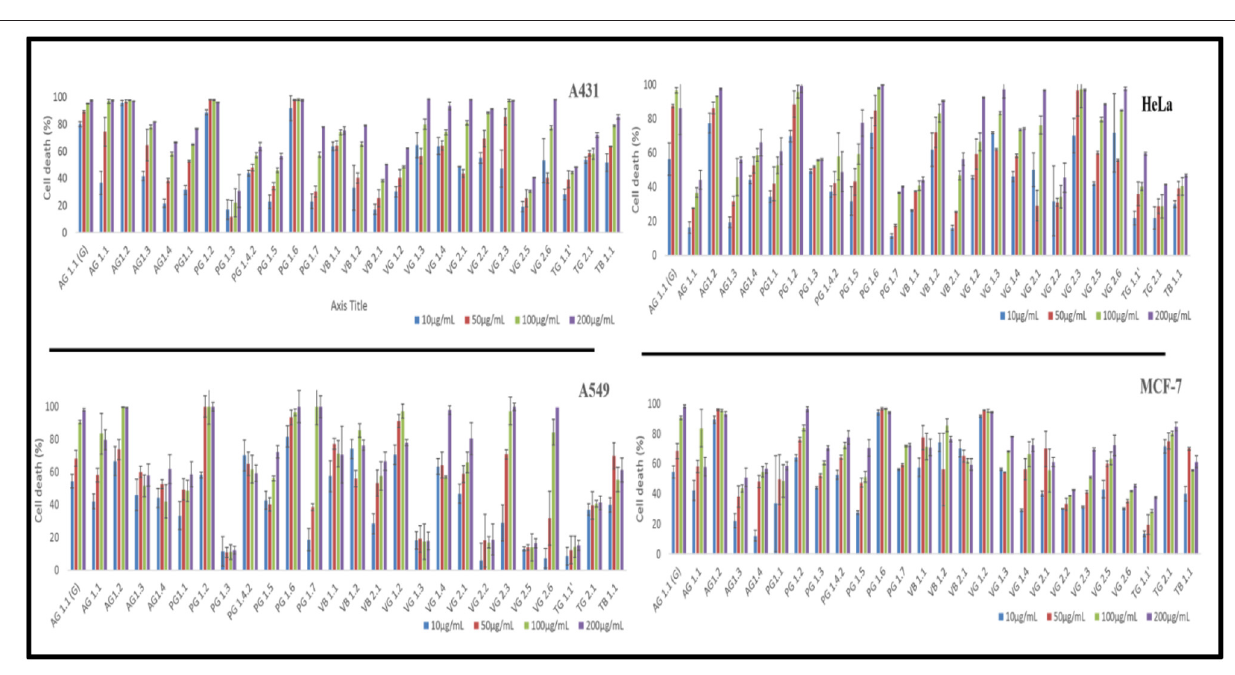
pathogens ( Table 3 ). AG1.1, AG1.1 (G), and VG2.6